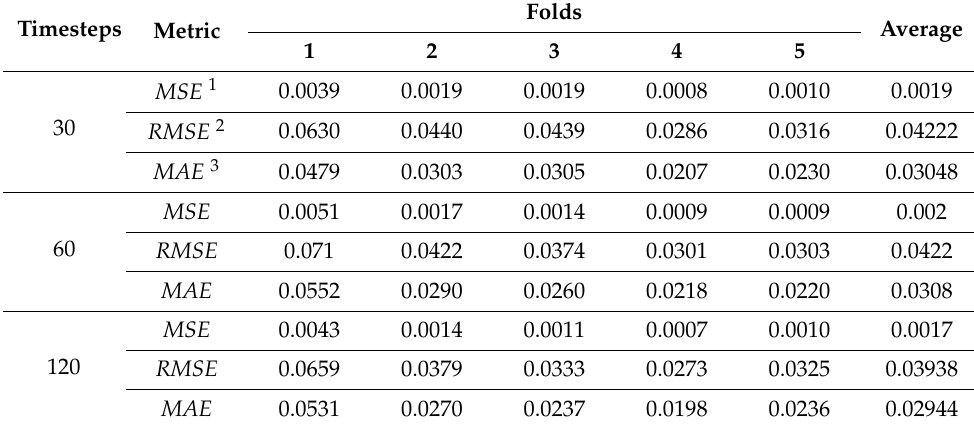
Table 3. Performance metrics for each timesteps during the great recession. Timesteps Metric